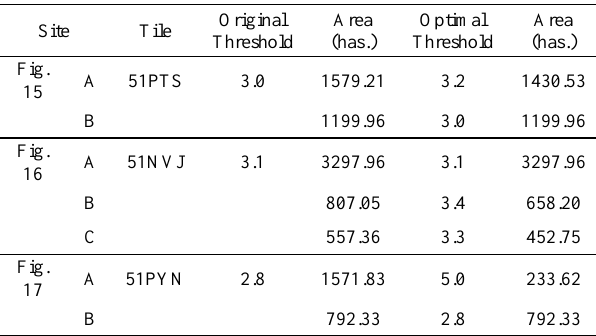
Table 2 . Comparison of computed areas of mangrove cover using the original and optimal site-specific thresholds in the sites with varying thresholds in Figures 15, 16, and 17.